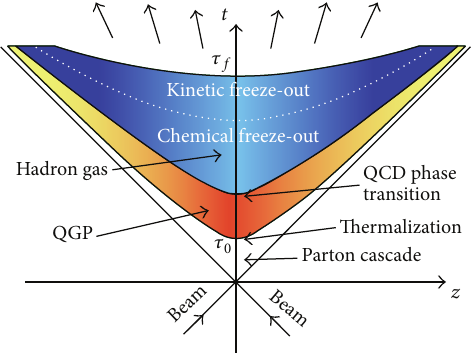
Figure1:Thespace-timeevolutionofheavy-ioncollision.Thefigure is taken from